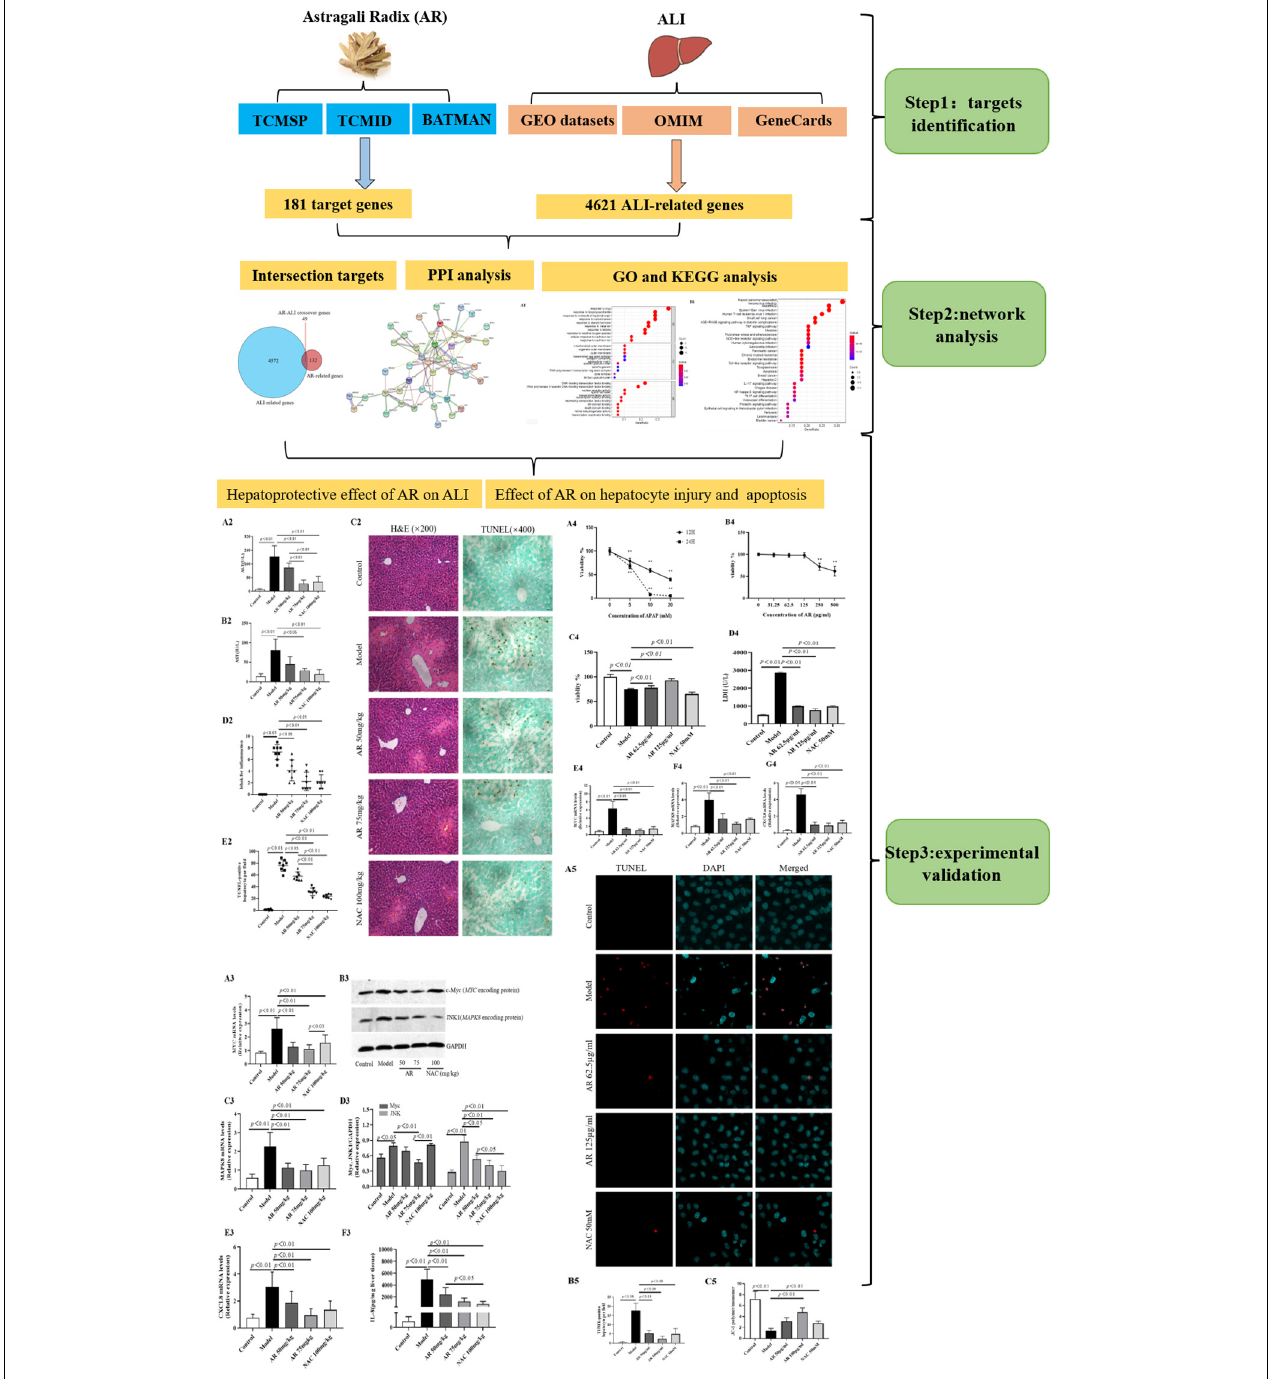
FIGURE 1 | Flowchart of the network pharmacological and experimental studies of Astragali Radix (AR) in APAP-induced acute liver injury